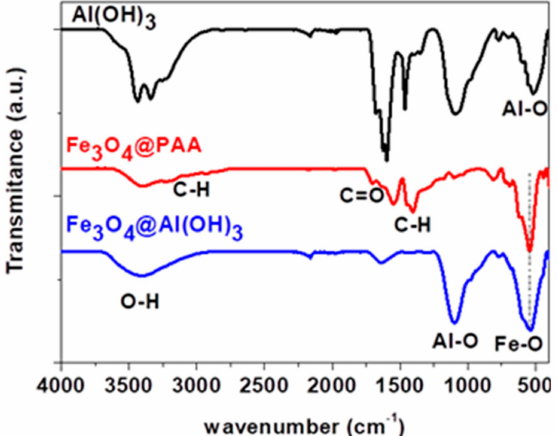
Figure 2. Fourier transform infrared (FTIR) spectra of aluminum hydroxide nanoparticles (NPs), magnetite coated with polyacrylic acid NPs and polyacrylic acid magnetic nanoparticles coated with aluminum